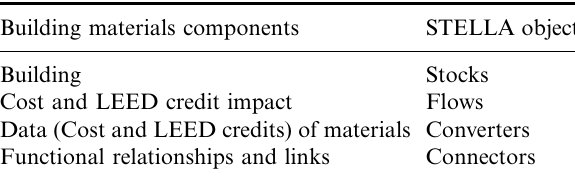
Table 1. Modeling building materials using